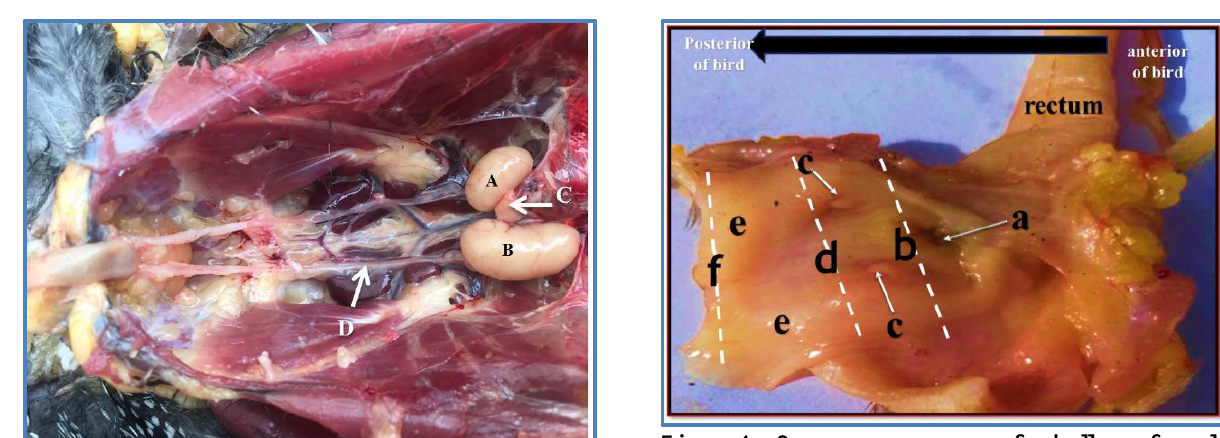
Figure,4. Gross appearance of phallus of male guinea fowl showing: orifice of rectum (a), coprodeum(b)bright and left papillae(c), urodeum (d), right and left lymphatic body(e) , proctodeum(f)